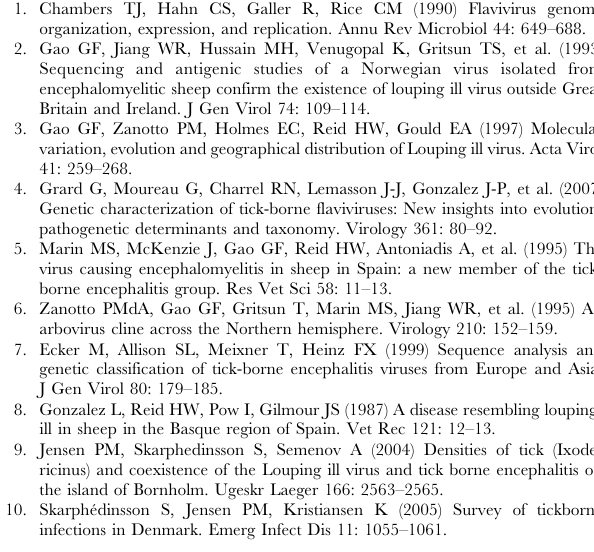
Node designations refer to Figure 5. Confidence intervals are indicated between brackets.